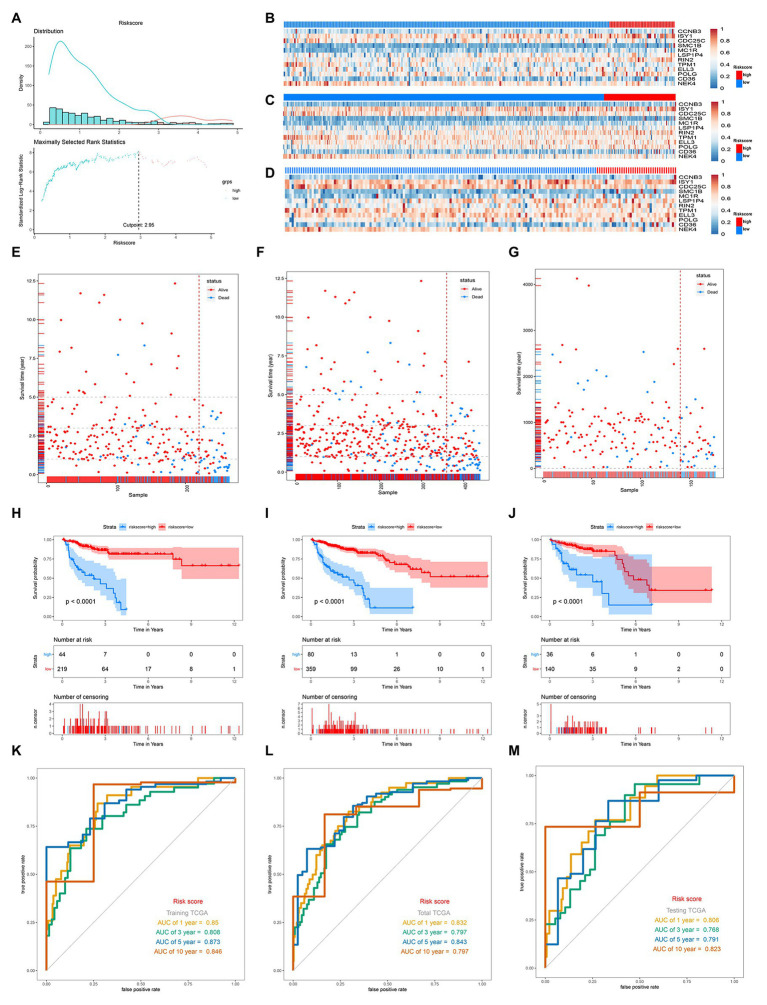
Distribution of risk score, Gene expression heatmaps, Kaplan-Meieranalysis and ROC analysis of 12-gene signature in the training TGCA set, total TCGA set, and testing set. (A) Distribution of risk score and the cutoff point. (B–D) Gene expression heatmaps in the training TGCA cohort (B), total TCGA cohort (C), and testing TCGA (D; The blue color is the low-risk group and the red color is the high-risk group). (E,F) Correlation between the prognostic signature and the OS of patients in the training TGCA cohort (E), total TCGA cohort (F), and testing TCGA (G). (H–J) Kaplan-Meier survival analysis of the low‐ and high-risk group patients in the training TGCA cohort (H), total TCGA cohort (I), and testing TCGA (J). (K–M) ROC curve analysis according to the 1, 3, 5, 10-year survival of the area under the AUC value in the training TGCA cohort (K), total TCGA cohort (L), and testing TCGA (M).